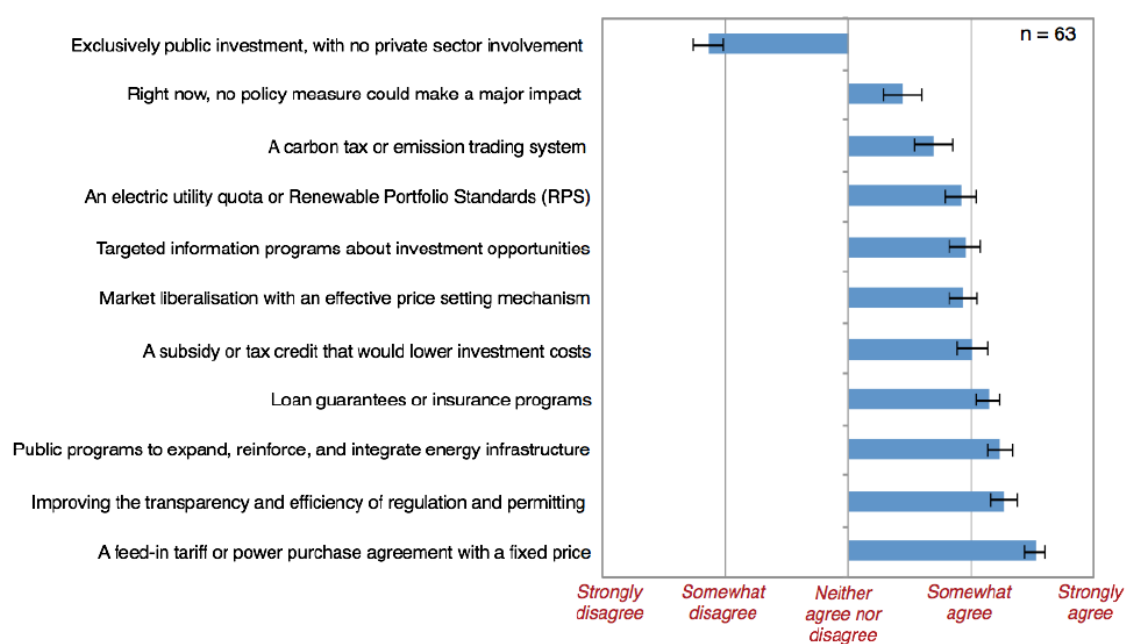
Figure 5. Results of question 4—policy solutions to overcome investment barriers and risks in the GCC countries.